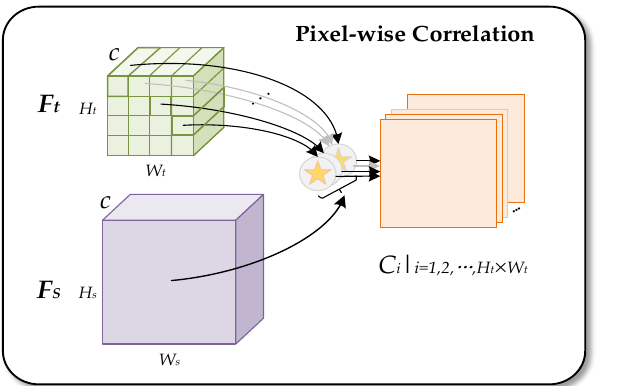
Figure 9. The schematic diagram of pixel-level correlation operation. The yellow star symbol denotes the naive correlation